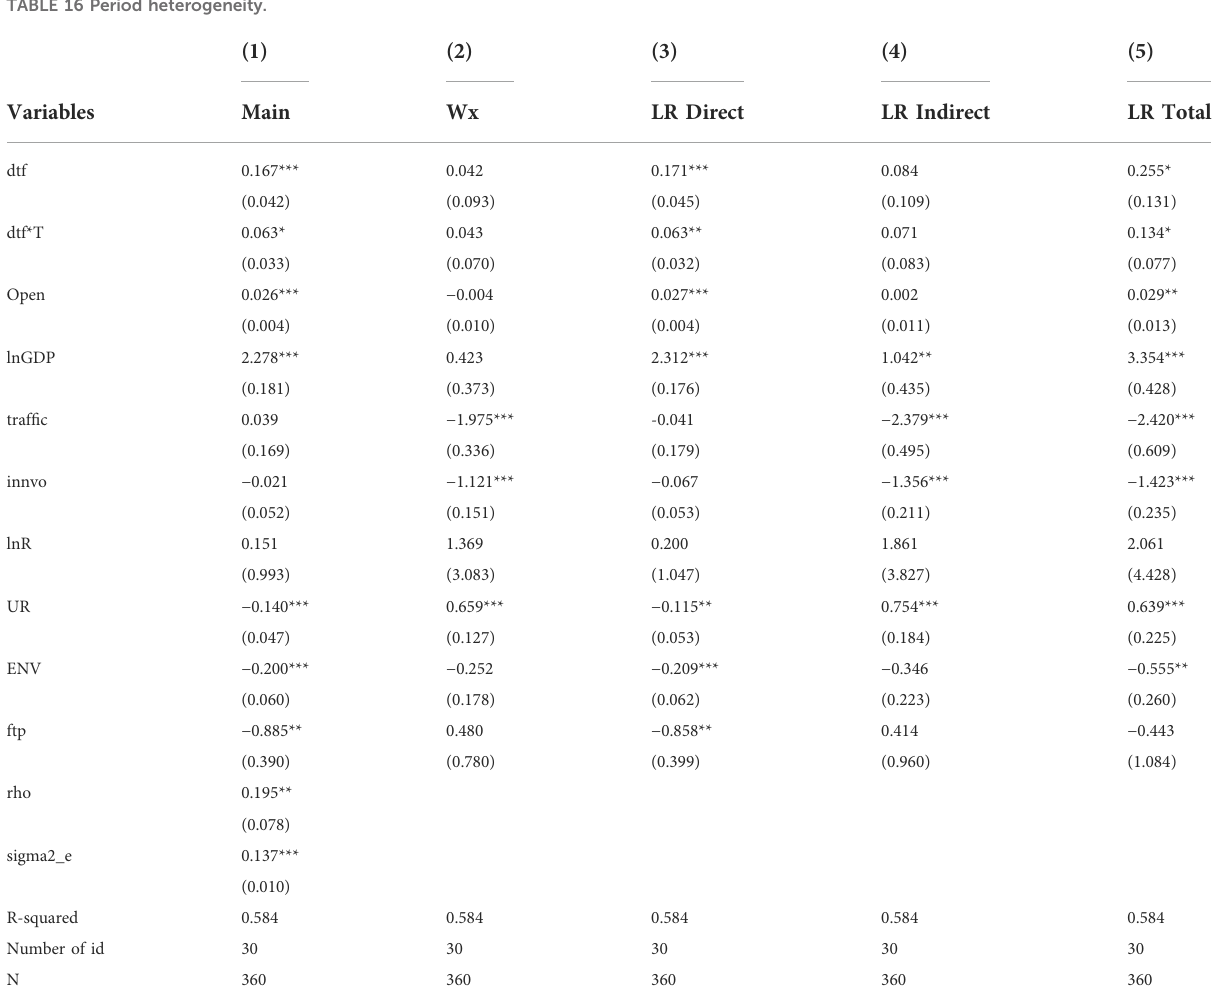
TABLE 16 Period